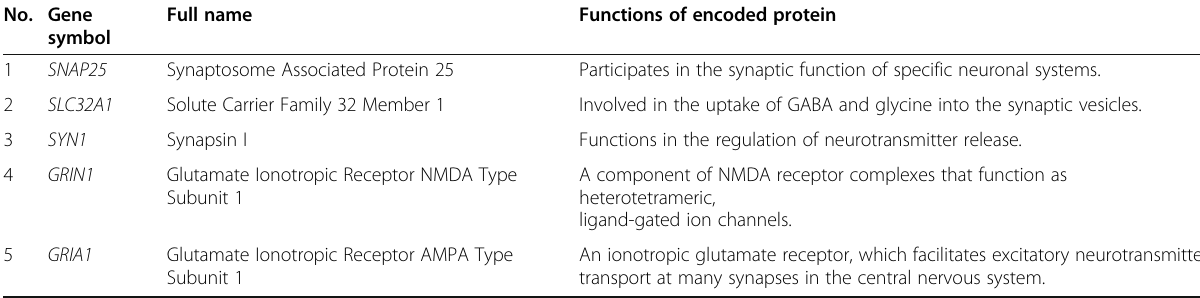
Table 3 Functional roles of the 5 hub genes No. Gene